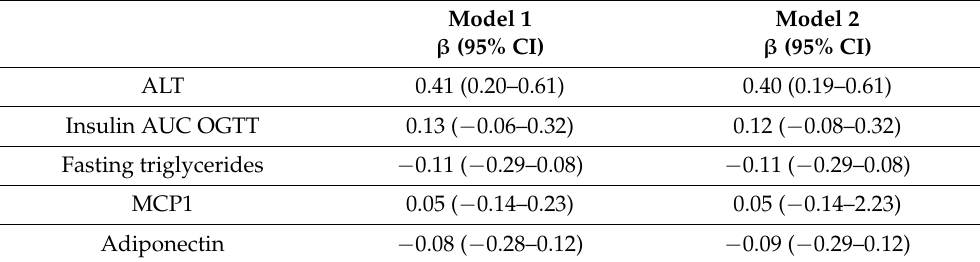
Table 4. Linear regression models of the association between the cytokeratin-18 plasma level and obesity-related biomarkers.